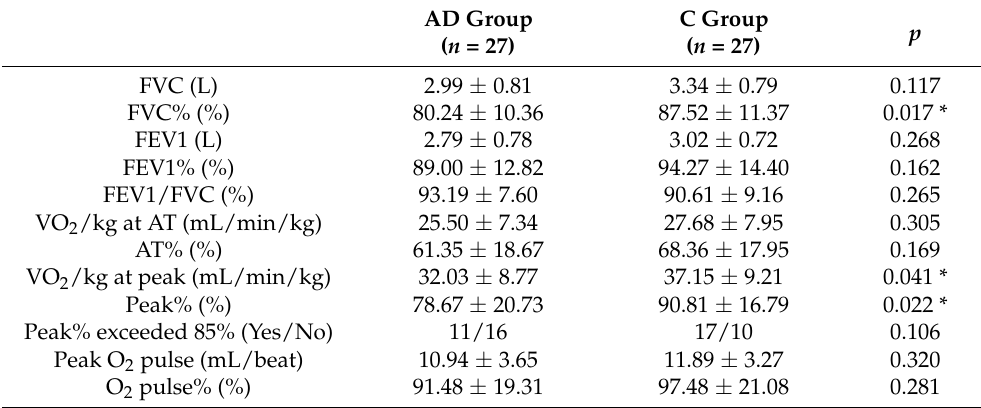
Table 2. Results of CPET in each